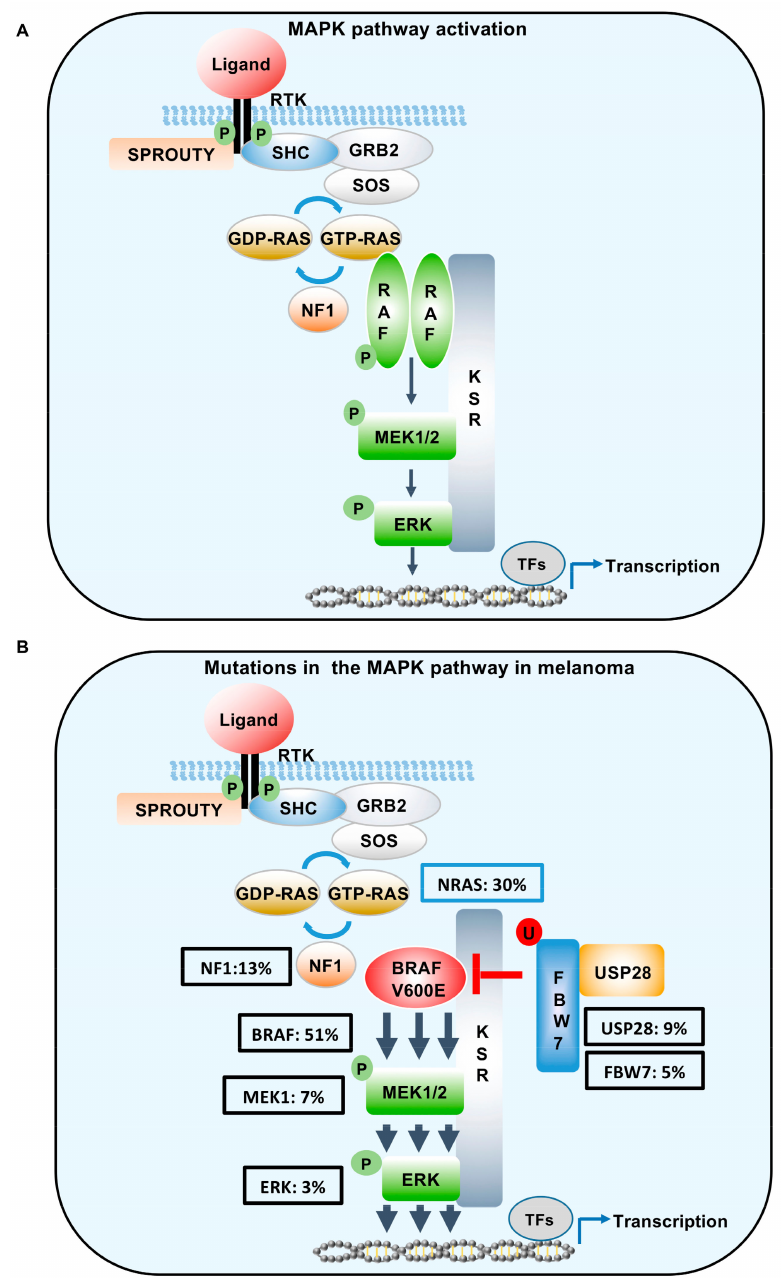
Figure 2. Schematic of MAPK signalling in the context of wild type BRAF and mutant BRAF V600E . ( A ) In cells expressing wild type BRAF, ligand-induced activation of RTKs enhances RAS-GTP activity resulting in the dimerization and activation of RAF family members. This binding serves to phosphorylate MEK1 / 2, which then phosphorylates ERK, resulting in ERK-mediated transcription. ( B ) Hyper-activation of the pathway in melanoma can occur through oncogenic mutations in NRAS, BRAF, MEK1, ERK, or the loss of function mutations in NF1, FBW7, and USP28. Class I BRAF mutations (V600E) function as monomers to engage the MEK / ERK signal cascade. Mutation statistics were extrapolated from cBioPortal [30]. SHC, SHC adaptor protein 1; GRB2, growth factor receptor bound protein 2; SOS, son of sevenless; RAS, RAS proto-oncogene; NF1, neurofibromatosis 1; FBW7, F-box and WD repeat domain containing 7; USP28, Ubiquitin specific protease 28; TF, transcription factors; MAPK: Mitogen-Activated Protein Kinase; BRAF: v-raf murine sarcoma viral oncogene homolog B; RTK: receptor tyrosine kinase; RAF: proto oncogene; MEK: mitogen-activated protein kinase; ERK: extracellular signal-related